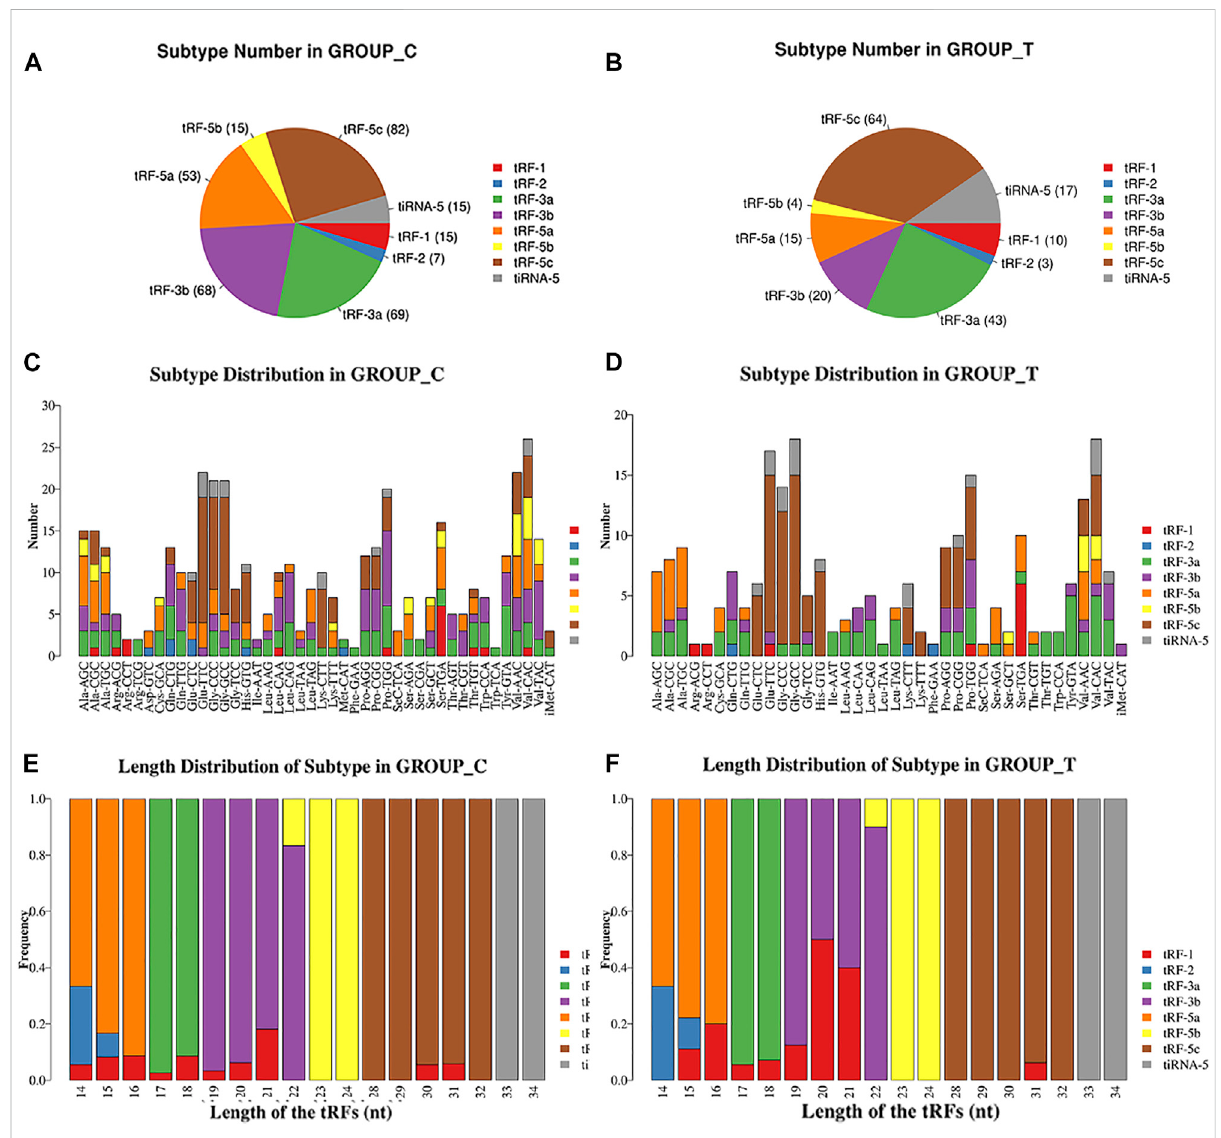
FIGURE 3 Pie chart and stacked bar chart. (A,B) Pie chart of tRFs/tiRNAs isoform distribution between the Exo-AT(C) and Exo-LT(T) groups. The values in brackets represent the number of tRFs/tiRNAs subtypes. (C,D) Stacked bar chart for all subtypes of tRFs/tiRNAs expressed in the Exo-AT(C) and the Exo-LT(T) groups clustered by the anticodon of the tRNAs. The X-axis represents the number of all the subtypes of tRNAs derived from the same tRNA anticodon, and the Y-axis shows the tRNAs with the same anticodon. (E,F) Stacked bar chart of the frequency of subtypes against the length of the tRFs/tiRNAs in the Exo-AT(C) and the Exo-LT(T) groups. The X axis represents the length of tRFs/tiRNAs and the Y axis shows the frequency of the subtype against thelength of the tRFs/tiRNAs. Besides, thebar with color represents the number of each subtype of tRF/tiRNA. The red, blue, green, purple, orange, yellow and brown colors represent the subtypes of tRFs and the gray color represents